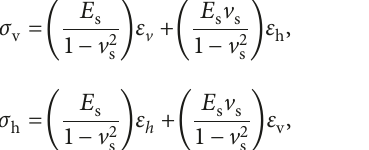
Figure 7: Strain analysis results on the steel tube of group-c specimens. Envelope curves of (A) load vs. strain and (B) load vs. ε 219-8, (b) 219-10, (c) 219-12, (d) 245-8, (e) 245-12, (f) 273-8, and (g)